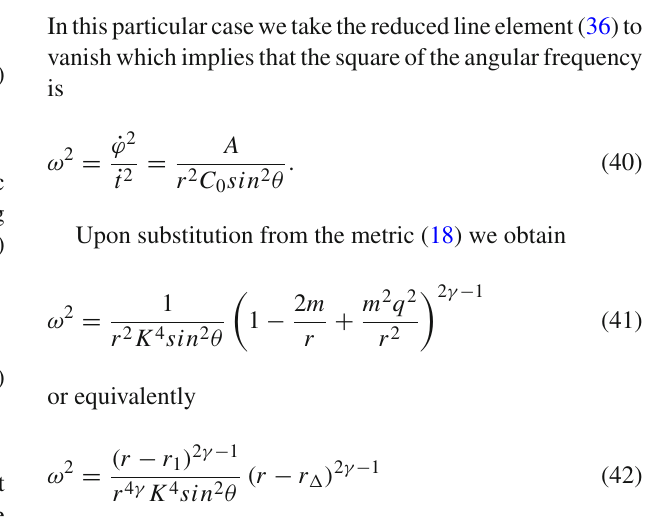
angular velocity